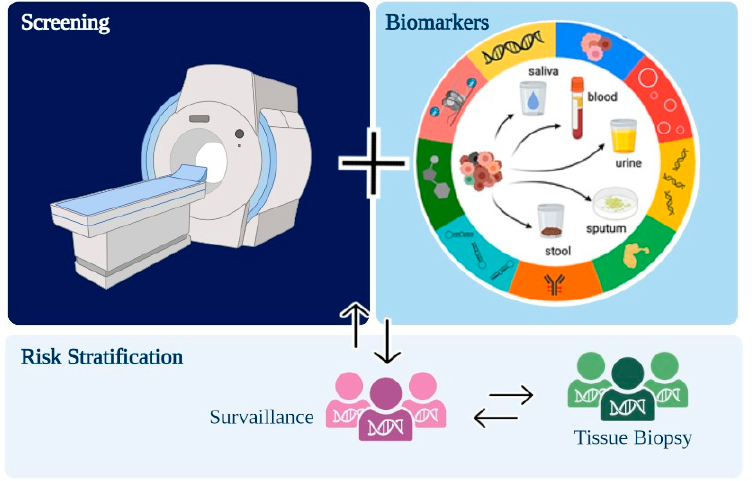
Figure 3. Purposed workflow for lung cancer screening programs associating low-dose computed tomography (LDCT) and minimally invasive biomarkers.